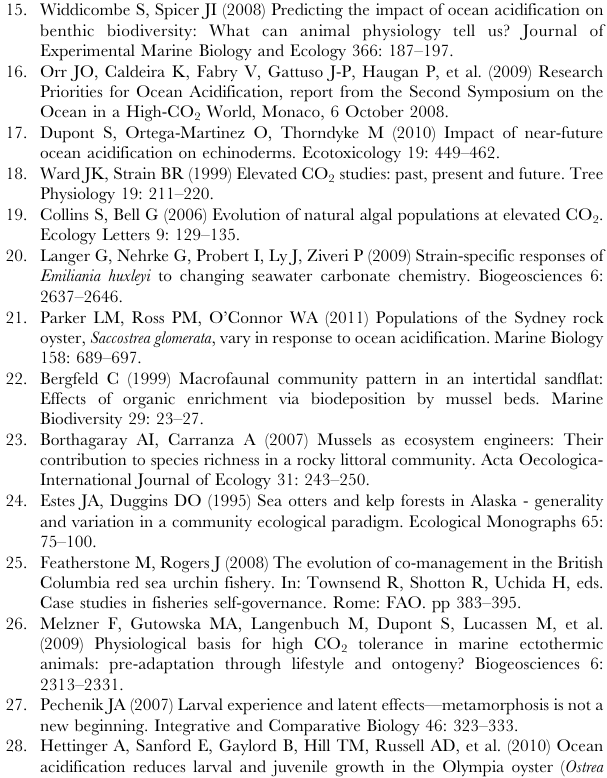
resultant fitness function (black) would center on the development time under low CO 2 for each species. (TIF) Figure S3 Separations in pH values between low (blue) and high (red) CO 2 treatments during experiments, for (A) M. trossulus and (B) S. franciscanus . Error bars indicate standard deviation. Although among-culture variance in pH was greater in the S. franciscanus experiment, variance in developmental responses attributed to culture jar was not included in calculation of genetic or phenotypic variance (culture effects were controlled for; see methods and Methods S1). (TIF) Figure S4 Effect of CO 2 treatment on Mytilus trossulus (A) and Strongylocentrotus franciscanus (B) larval size. Mean size from each culture is shown in grey, and data aggregated by sire and dam combination (family mean) are shown in black. Segments connect family means at high and low CO 2 treatments.